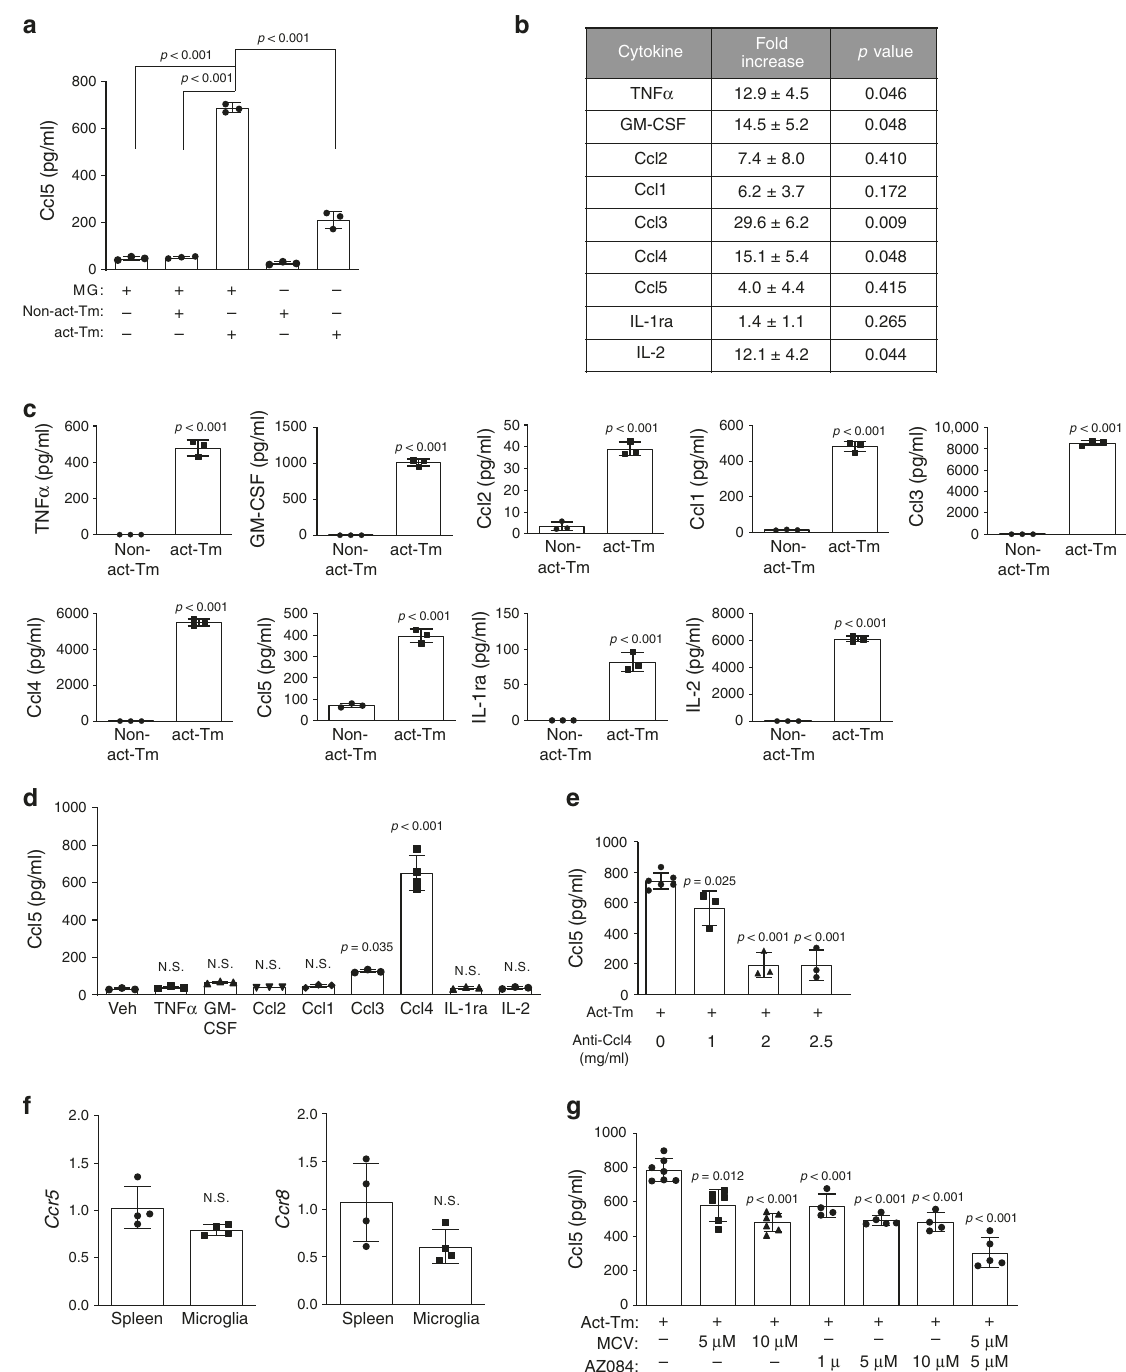
merase chain reaction (qRT-PCR) validation revealed increased MDK , but not CSF2 , mRNA expression in NF1 -null, relative to control, neurons (Supplementary Fig. 3b, c). In contrast, increased CSF-2 protein levels were detected by ELISA in the CM of both NF1 -null neurons relative to control neurons, but at much lower levels relative to MDK [CSF-2: 100 – 300 pg ml − 1 (Supplementary Fig. 3d), MDK: 40,000 – 50,000 pg ml − 1 (Fig. 2a)]. Neuron-derived MDK or CSF-2 could in fl uence T cell biology in two ways. First, it could function as a chemoattractant for T cells. However, CD3 + T cell migration measured using